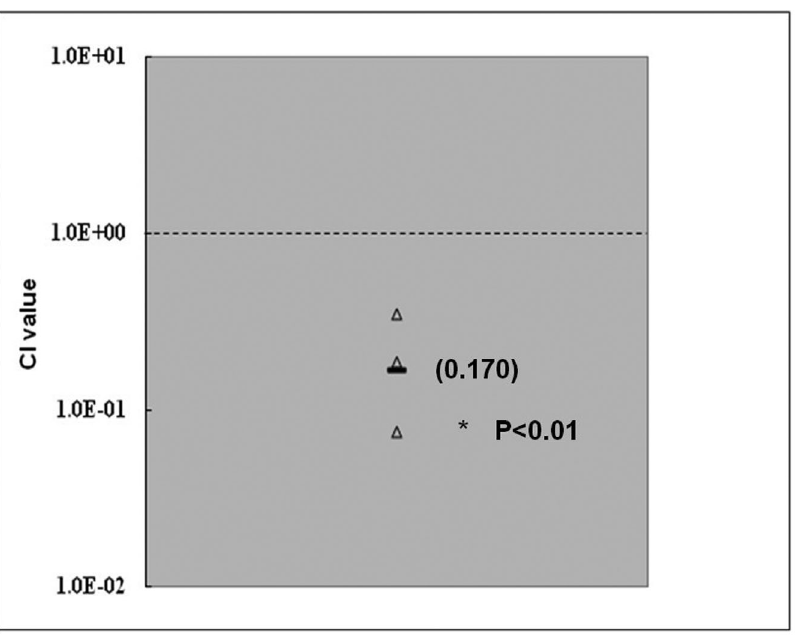
Figure 6. Invivo competitive index analyses of D spxA1 . The dashed line denotes a CI value of 1, indicating equal competitiveness. Each symbol indicates the CI value derived from a single animal; solid horizontal lines indicate geometric mean values. Mean CI values from 3 rabbits tested are indicated in parentheses. Paired t tests were used to determine whether CI values were significantly different from 1, with a =0.05. *P , 0.01. Open triangle: in vivo CI analysis from 3 rabbits.